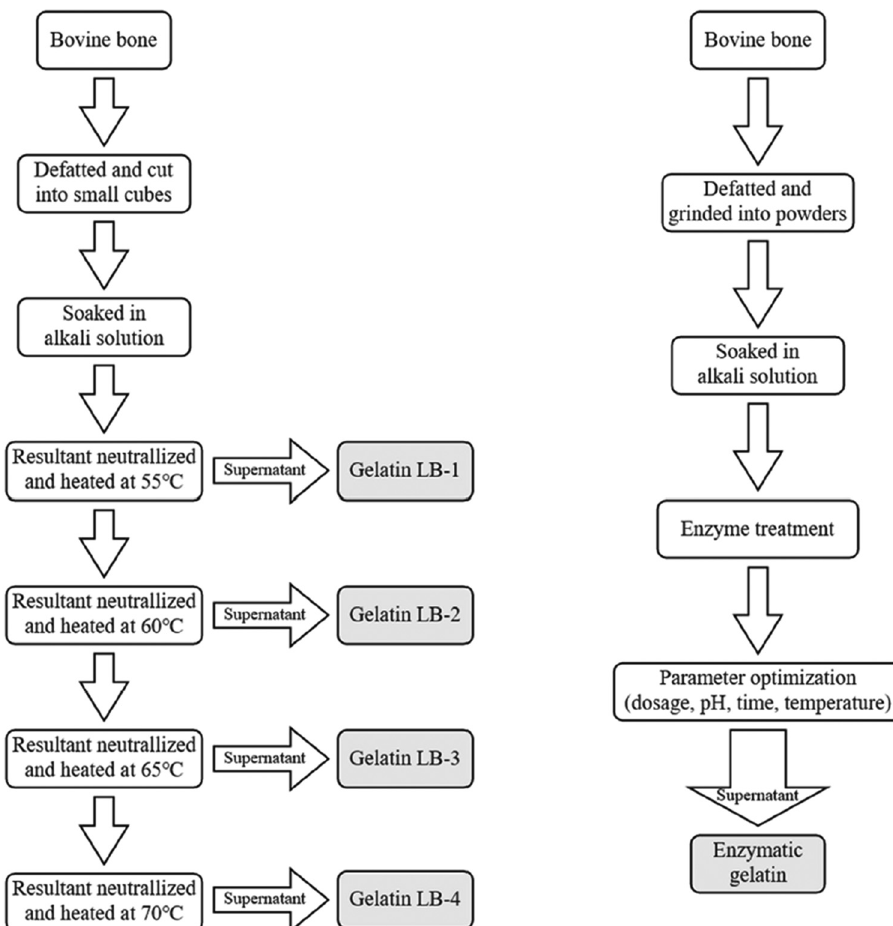
Figure 1: Schematic diagram of extractions of alkaline gelatin and enzymatic